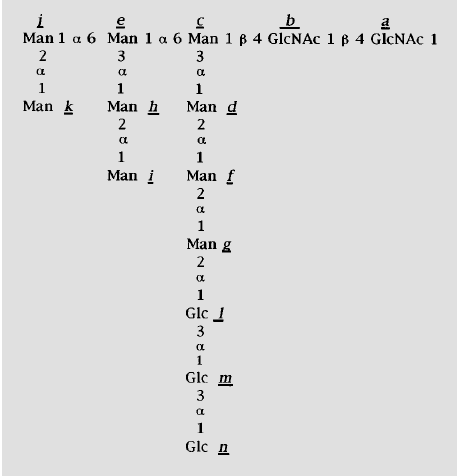
Figure 1 - Structure of oligosac- charides. The structure is that of the oligosaccharide transferred to proteins in wild type mamma- lian, plant and fungal cells. The lettering used for the identifica- tion of the individual monosac- charide residues ( a, b, c , ...) fol- lows the same order as the addi- tion of the monosaccharides in the assembly of the oligosaccha- ride. The oligosaccharides with compositions Man 9 GlcNAc 2 , Man 7 GlcNAc 2 and Man 6 Glc NAc 2 transferred in different trypanosomatid species are de- void of residues l, m and n , or of j, k, l, m , and n or of i, j, k, l, m and n ,